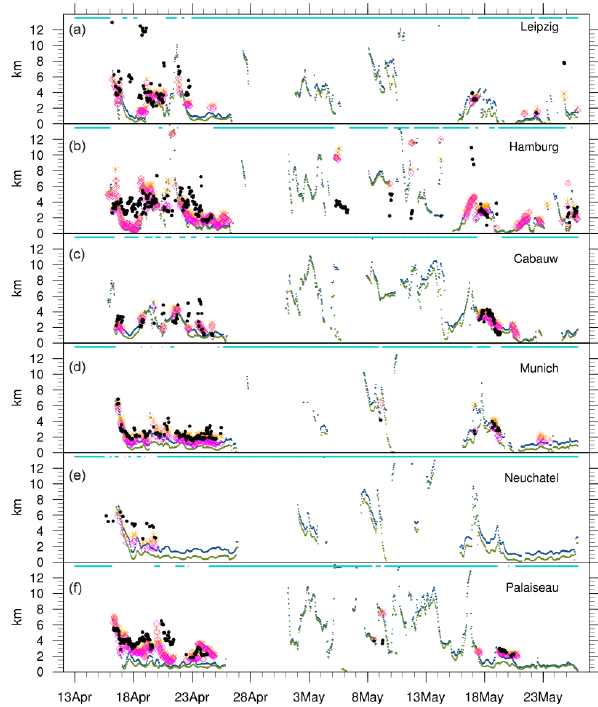
Figure 9. Modelled and observed centres of mass for ash at the li- dar stations. Green and blue dots represent the centre of ash mass, computed from the entire model column, for simulations with and without gravitational settling, shown where ash concentrations were larger than 0.1µgm − 3 . Magenta and orange represent the model centre of ash, calculated above the observed planetary boundary layer (PBL) with and without gravitational settling respectively. Black dots are the corresponding lidar retrieved centre of mass for ash above the PBL (same as Fig. 7). The light blue line above indi- cates where observations are